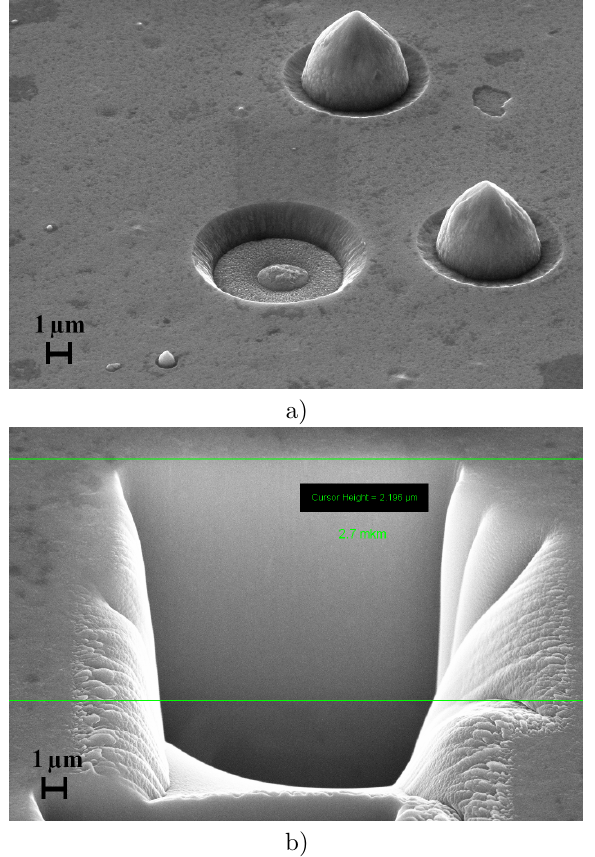
Figure 2. ZrN coating research using SEM: a) arte- facts of deposition; b) coating